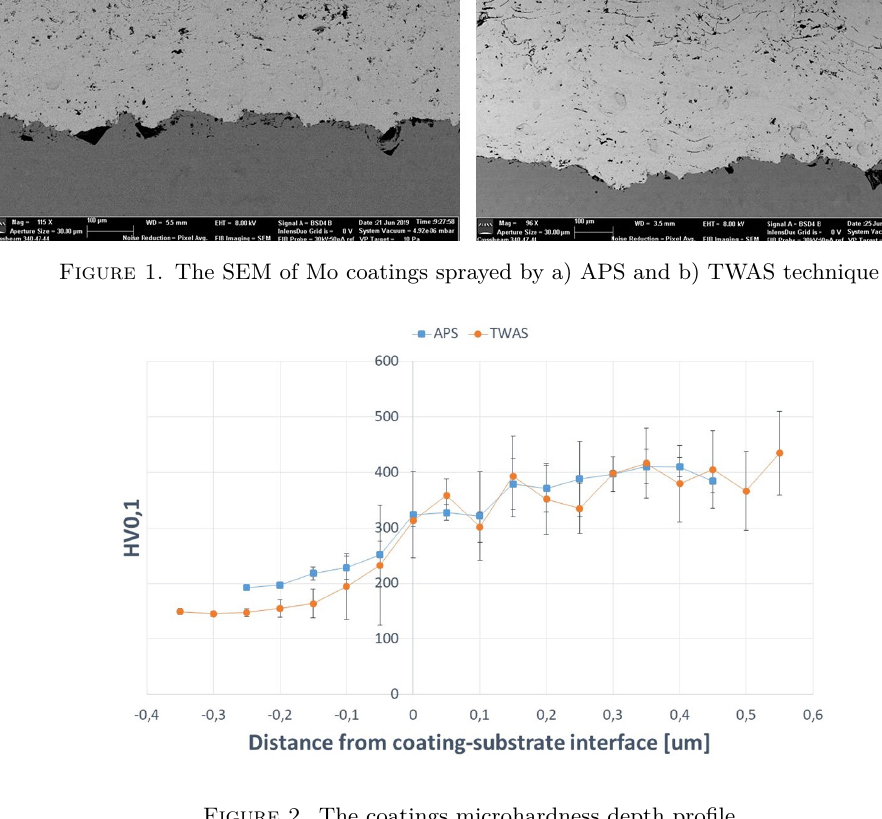
Figure 2. The coatings microhardness depth